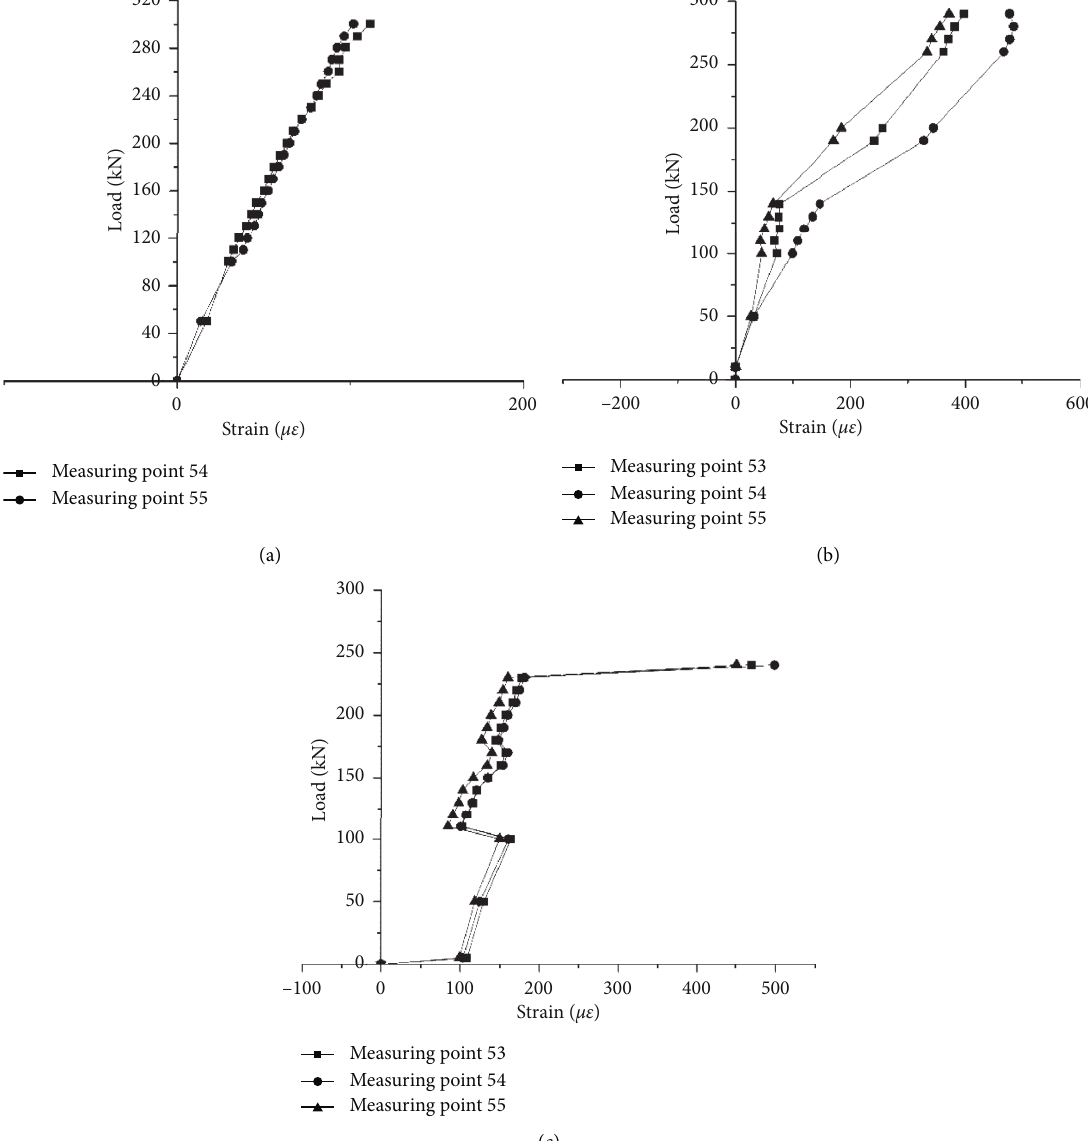
Figure 13: Strain-load curves for each measuring point at the bottom of the specimens: (a) SP1, (b) SP4, and (c)